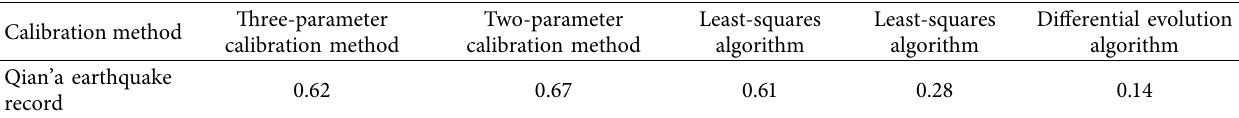
Table 5: Standard deviation list of the five calibration methods.